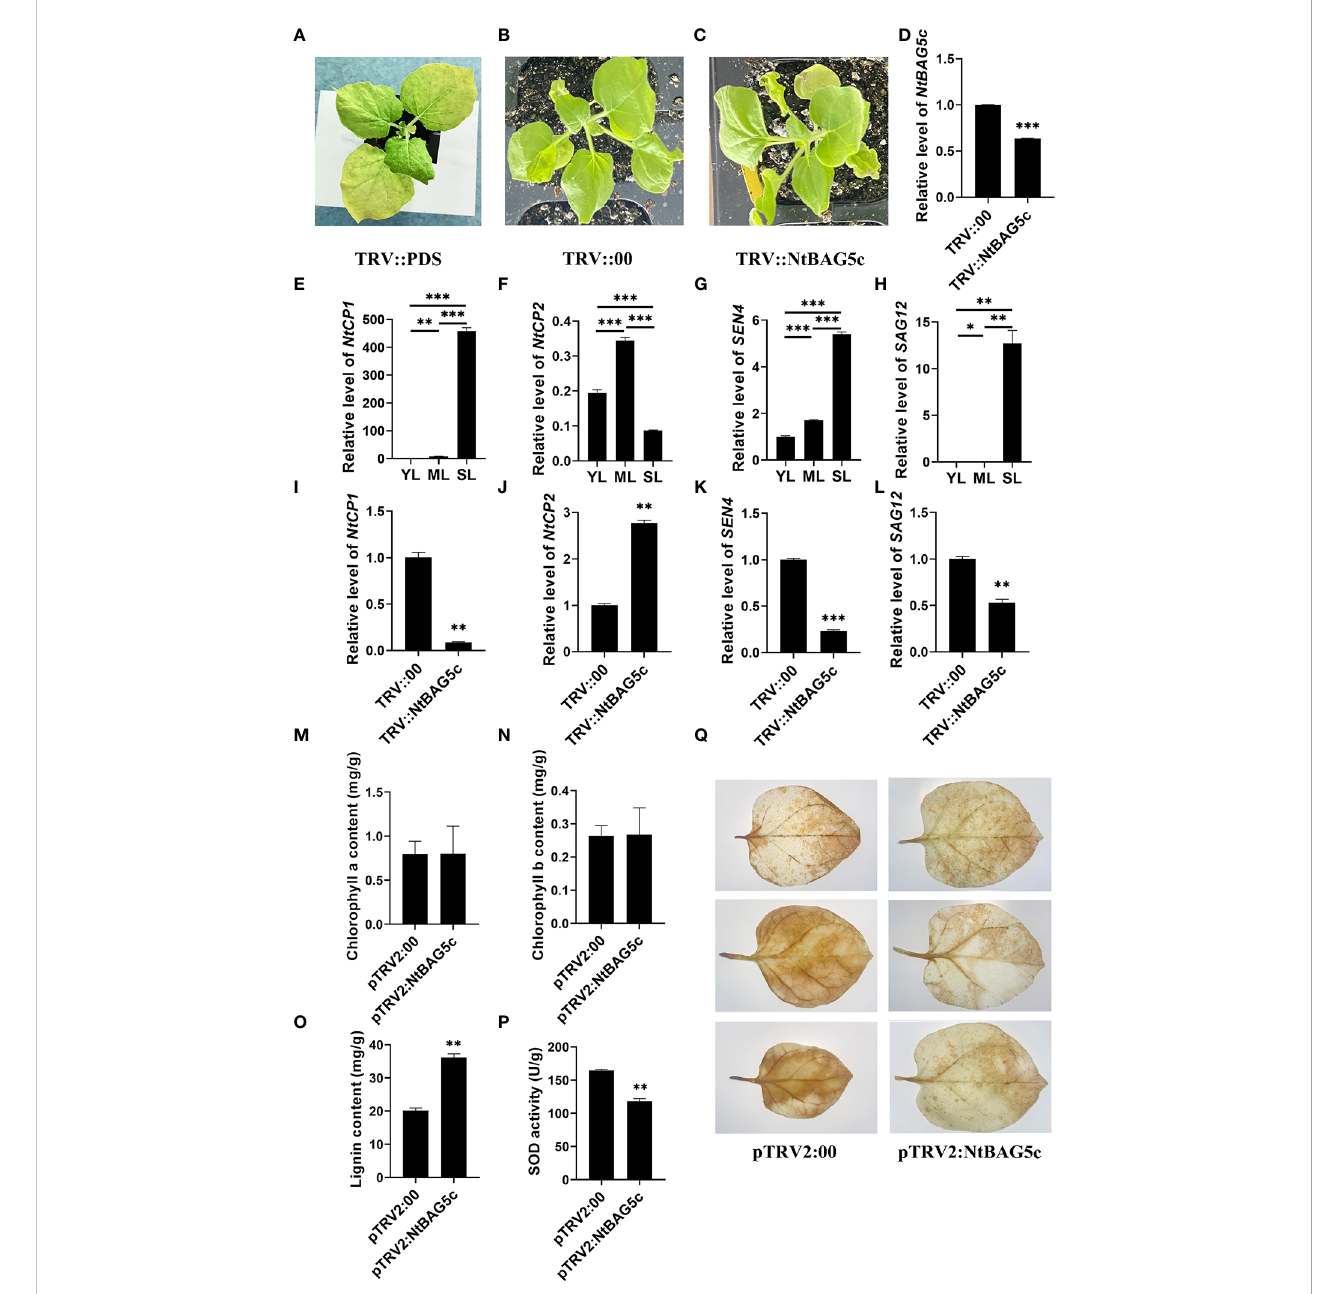
FIGURE 6 Silencing of NtBAG5c in Nicotiana tabacum using a tobacco rattle virus (TRV)-based VIGS system. (A – C) Phenotypes of tobacco plants after 10 days of VIGS. (A) PDS control plants ( TRV::PDS ); (B) negative control plants ( TRV::00 ); (C) NtBAG5c-silenced plants ( TRV::NtBAG5c ). The expression levels of NtBAG5c (D) , NtCP1 (E) , NtCP2 (F) , SEN4 (G) , and SAG12 (H) in plant leaves at different developmental periods, as determined by qRT-PCR. The expression levels of NtCP1 (I) , NtCP2 (J) , SEN4 (K) , and SAG12 (L) in NtBAG5c-silenced plants by qRT-PCR. (M) Chlorophyll a content. (N) Chlorophyll b content. (O) Lignin content (mg/g). (P) SOD activity (U/g). (Q) DAB staining of isolated leaves of pTRV2:00 and pTRV2:NtBAG5c. Results were reproduced in three independent experiments using three plants each. All data are presented as the mean (±SEM) of three independent biological